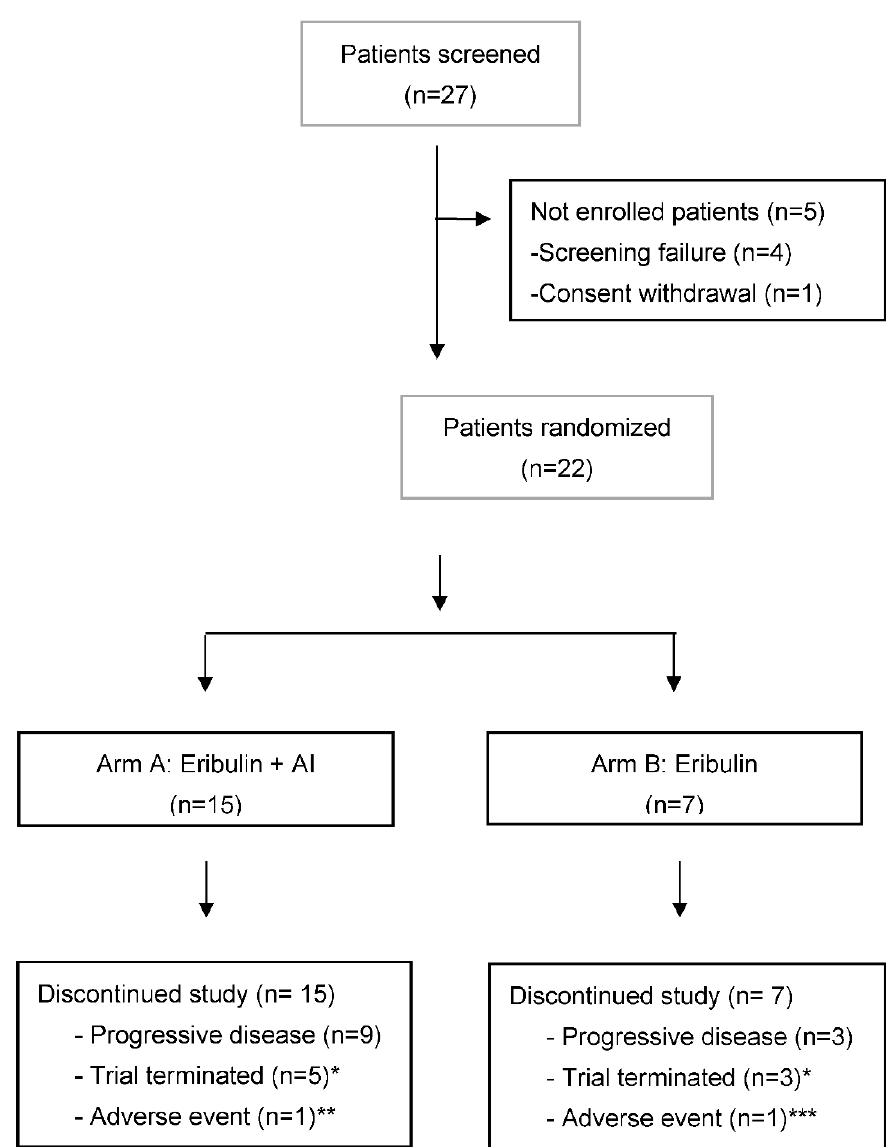
Figure 1. Patient disposition. * Patients continued the treatment outside the clinical trial. ** Grade 3 peripheral neuropathy related to eribulin. *** Grade 3 pneumonitis unrelated to study treatment.